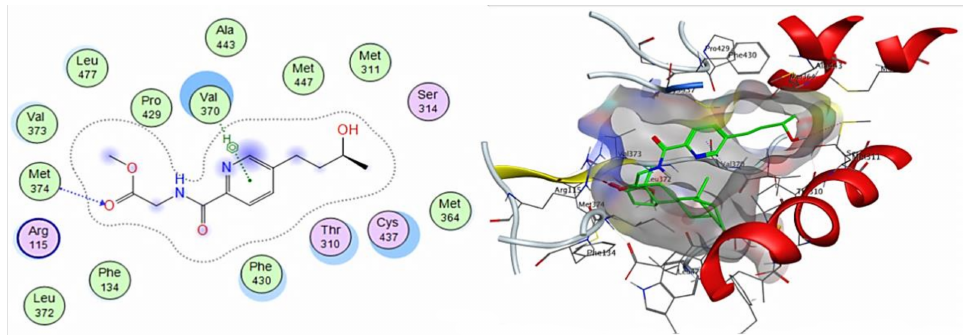
Figure 10. The 2D and 3D interactions of atransfusarin with human aromatase cytochrome P450 active